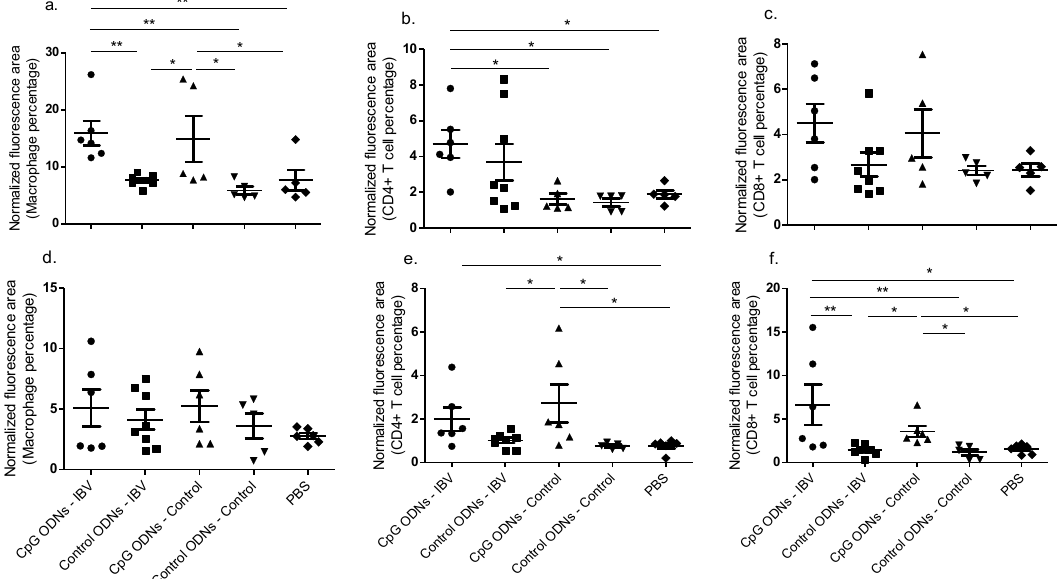
Figure 2. In ovo delivery of CpG ODNs is capable of recruiting key cells of the innate and adaptive arms of the immune system responsible for enhanced immune responses in the respiratory